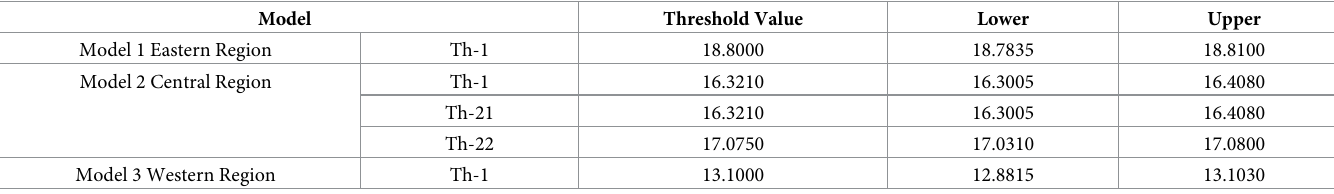
Table 15. Threshold value